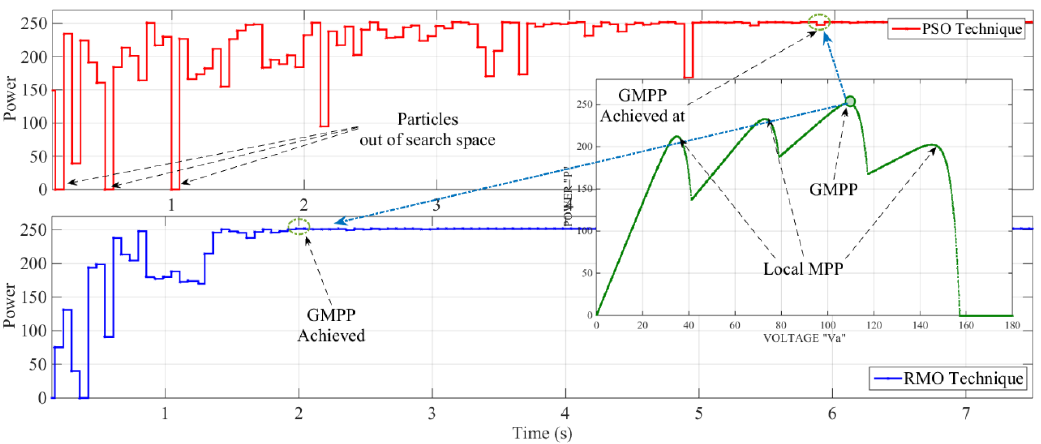
Figure 12. The output results of the proposed method and PSO method under shading condition in third scenario.